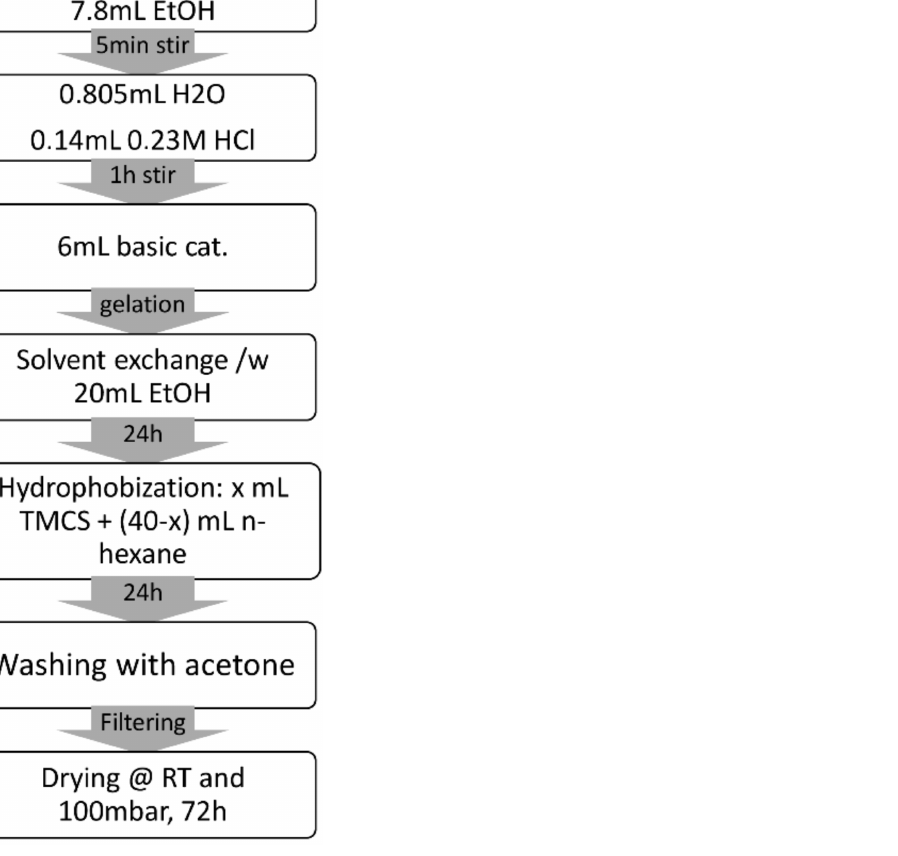
Figure 7. Sol-gel preparation procedure used in the present investigation. Compared to our recent published results, all steps are performed at room temperature and the solvent exchange is two times